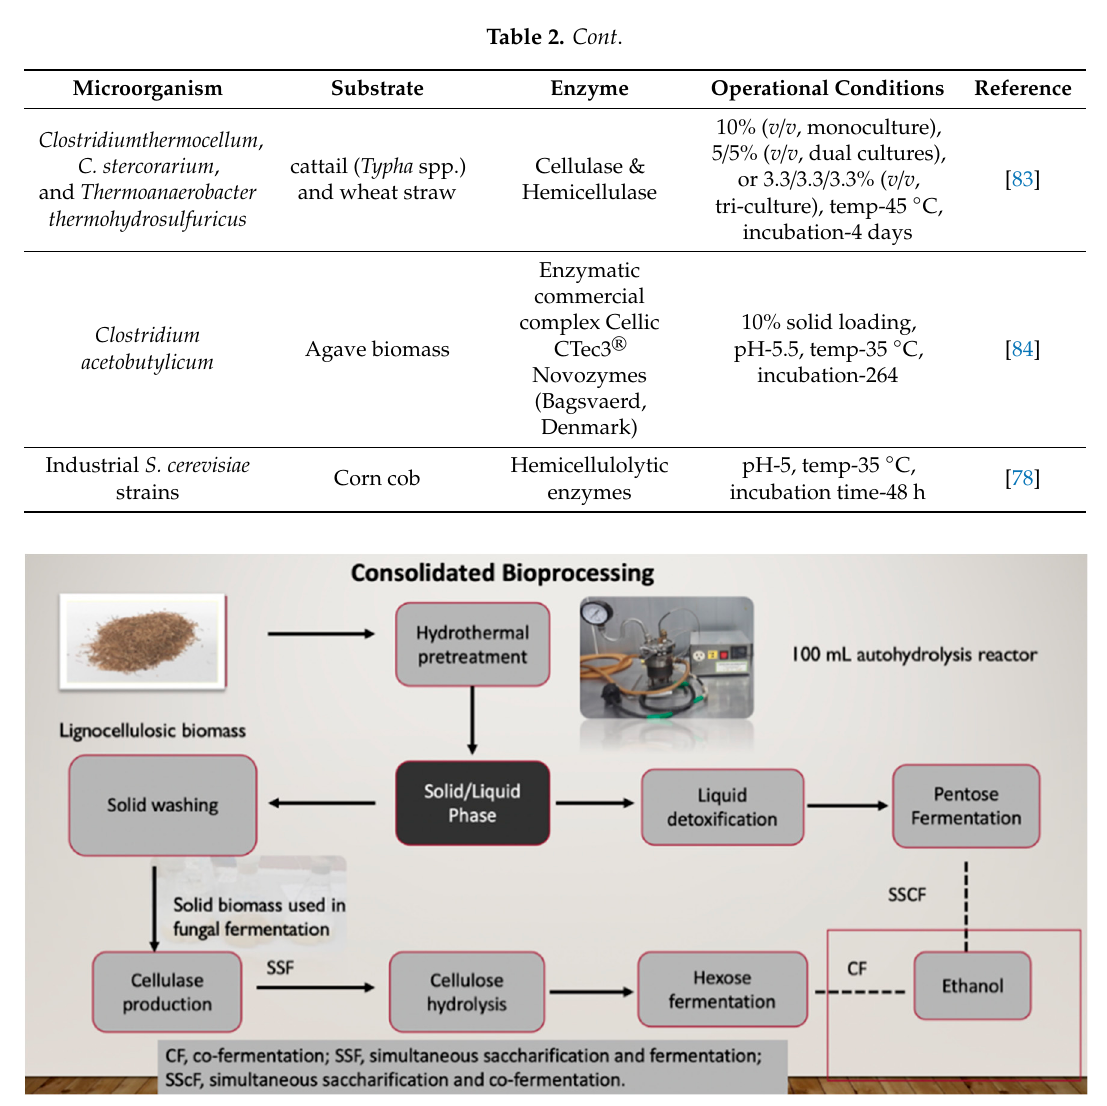
Figure 3. Schematic representation of consolidated bioprocessing processing using as hydrothermal strategy pretreatment. Adapted and modified from [15].